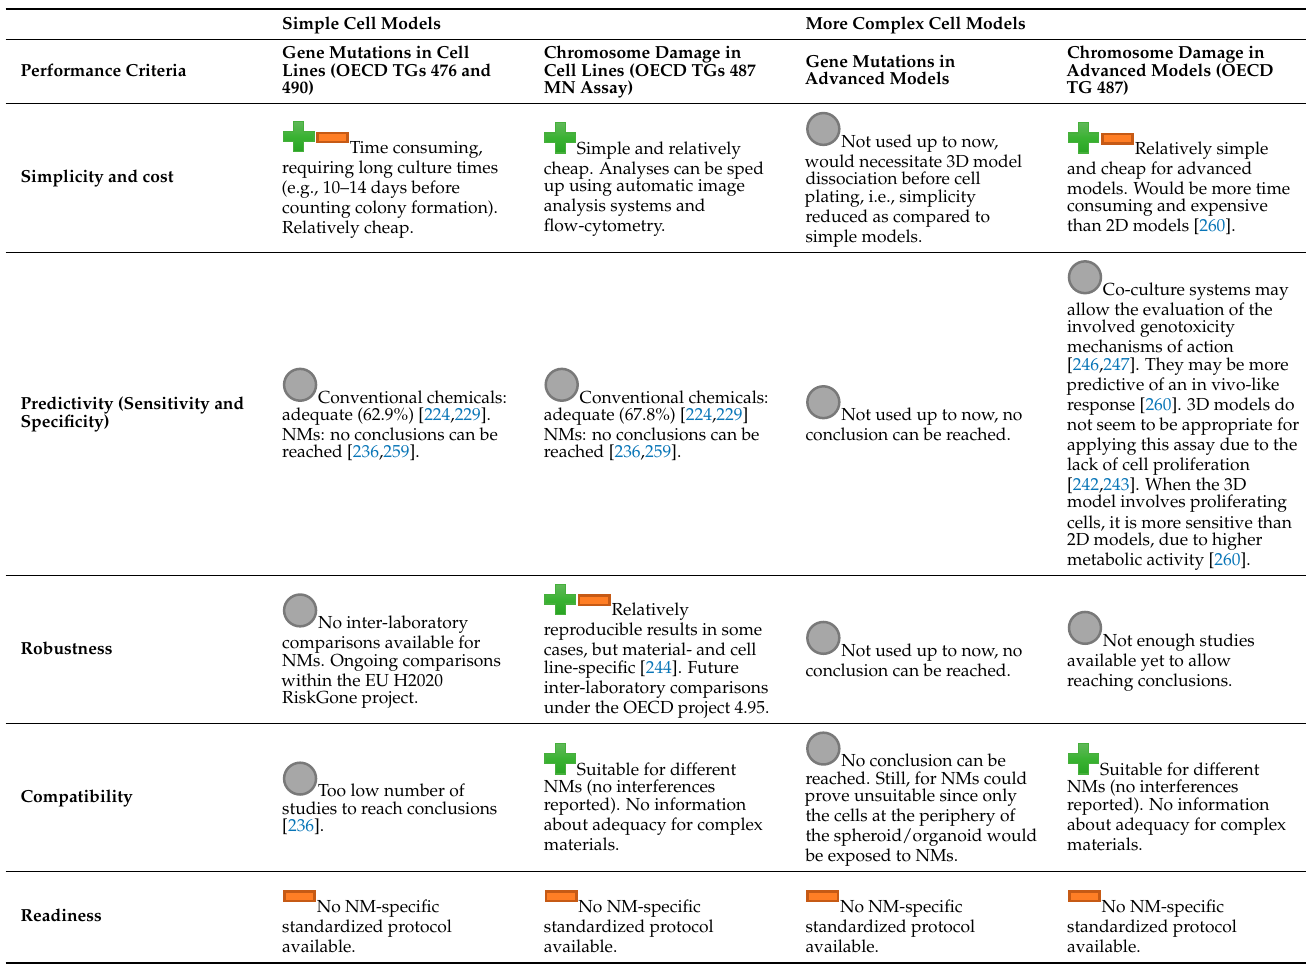
Table 5. Evaluation of suitability of genotoxicity assays for SbD hazard testing.